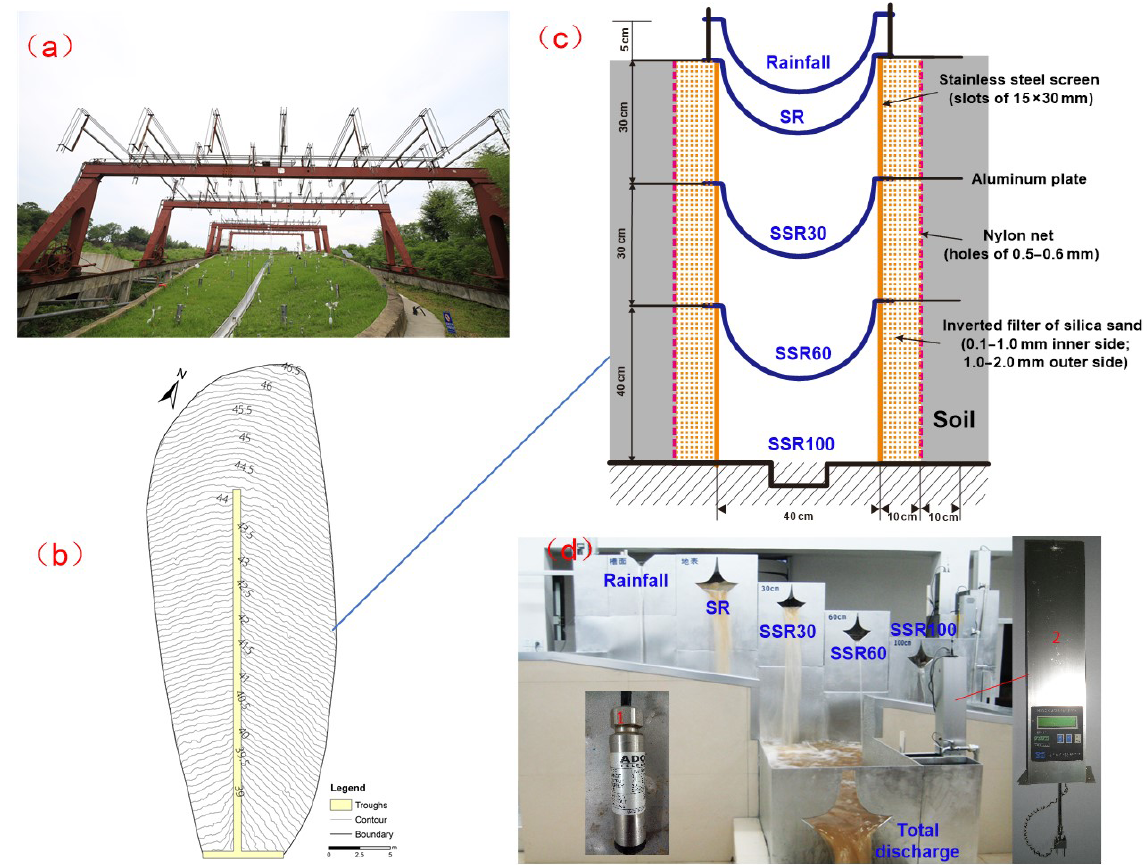
Figure 1. Aerial view of the Hydrohill experimental catchment and measurements of runoff components, (a) aerial view of the Hydrohill catchment with observation devices, (b) contour line on the Hydrohill catchment, (c) and (d) , runoff components measuring system at the outlet of the Hydrohill catchment. SR: surface runoff; SSR30, SSR60, and SSR100: subsurface runoff from soil layers of 0–30, 30–60, and 60–100cm in depth.